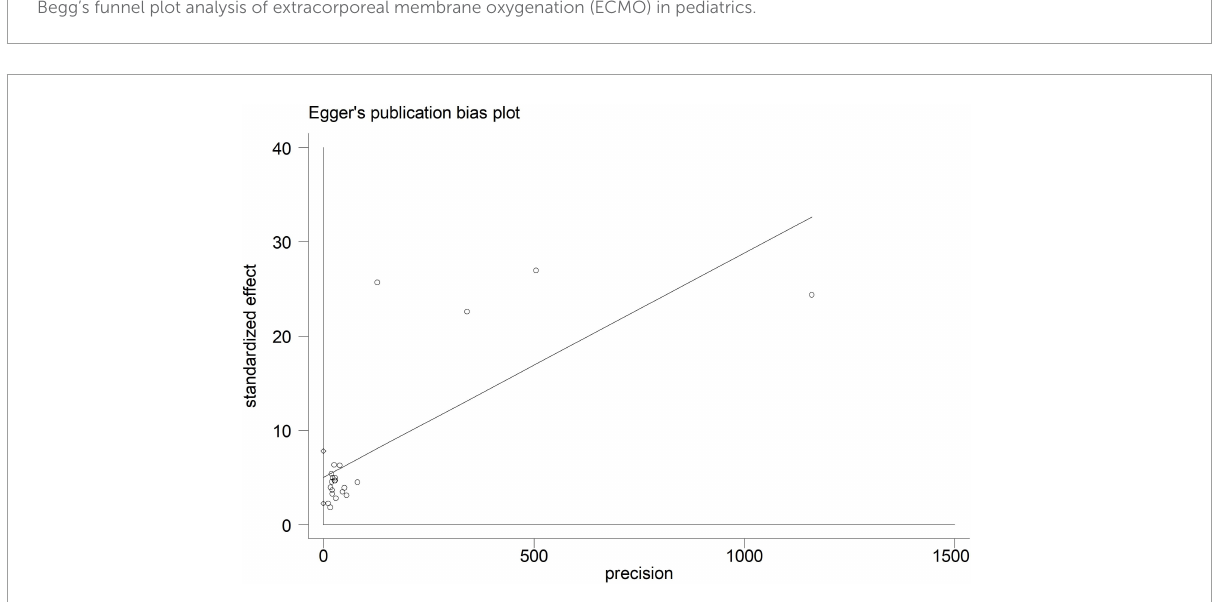
FIGURE9 Egger’s funnel plot analysis of extracorporeal membrane oxygenation (ECMO) in